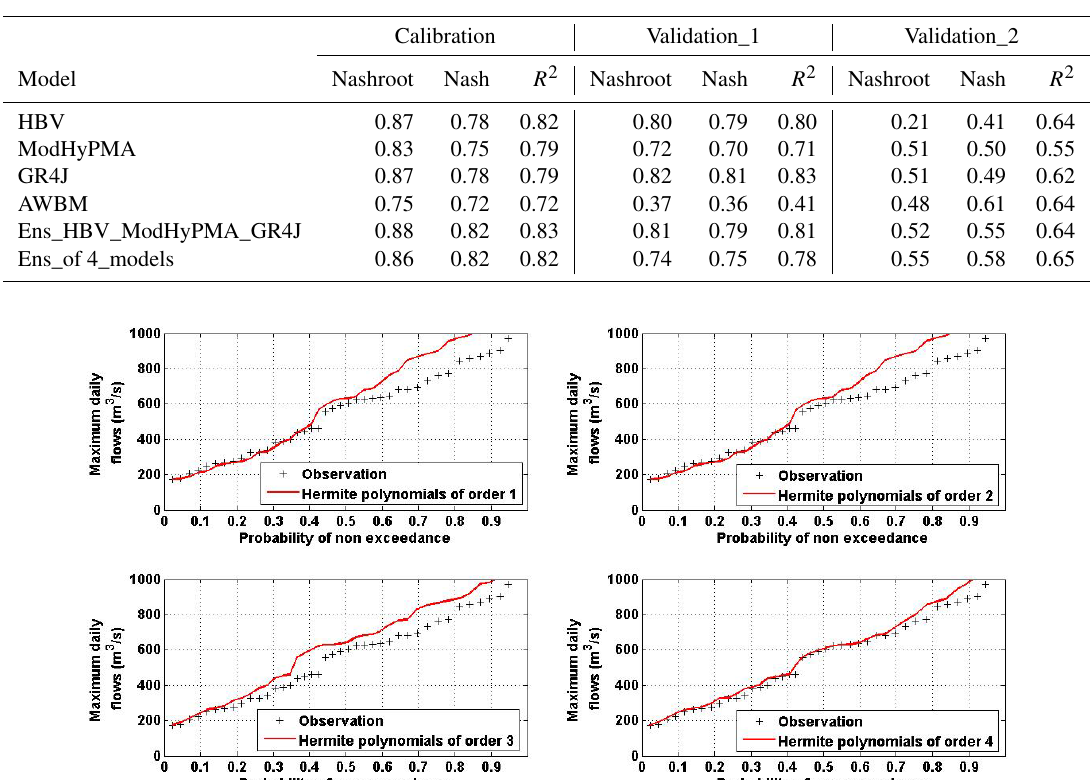
Figure 4. Fitting curve of the probability distribution based on Hermite polynomials for the simulated maximum daily flows in the Mono basin at